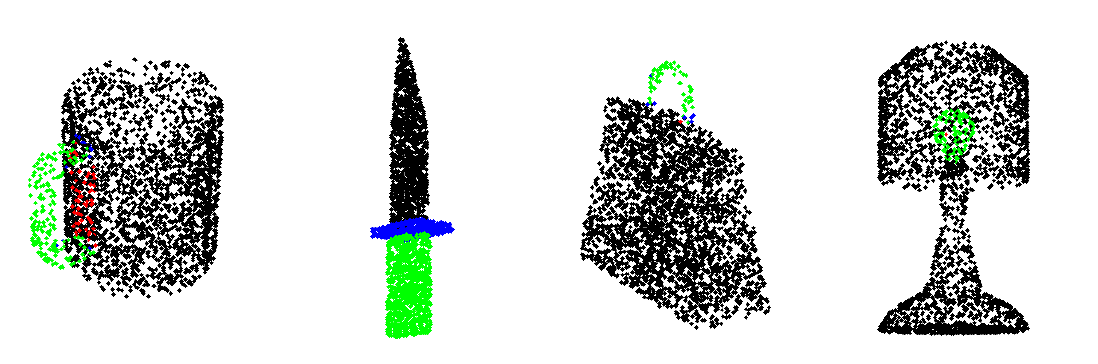
Figure 5. Sample